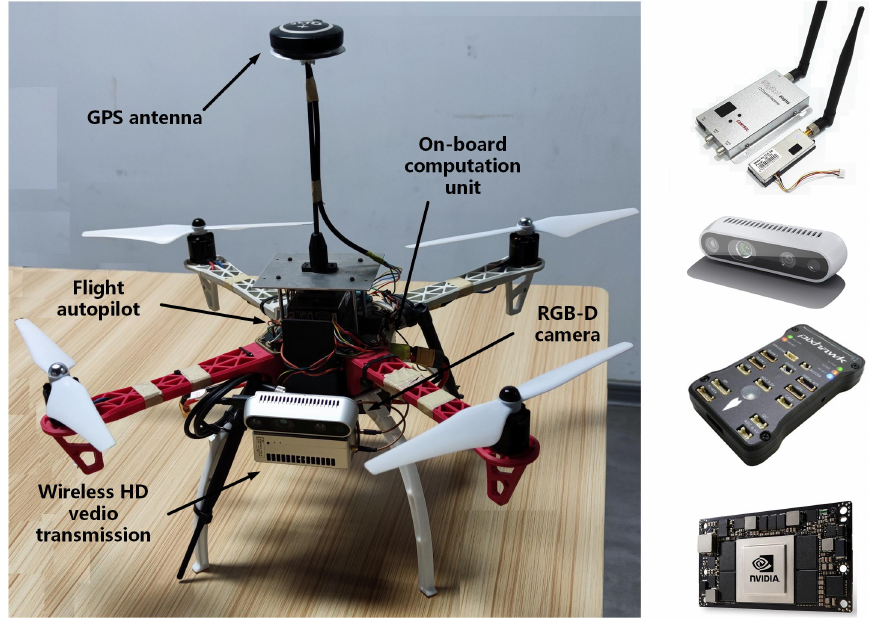
Figure 5. Our UAV platform equipped with several